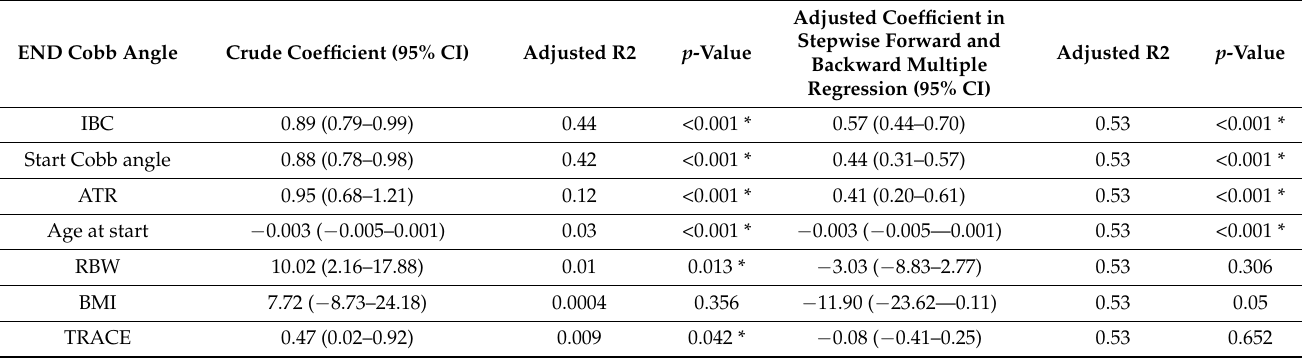
Table 2. The crude and adjusted coefficient of the multivariable linear regression model of the Cobb angle at the end of treatment. RBW = Real Brace Wear, IBC = in-brace correction, in Cobb degrees difference and percentage. * Level of significance set to <0.05. RBW, age at start BMI, and TRACE were automatically dropped by the backward and forward stepwise